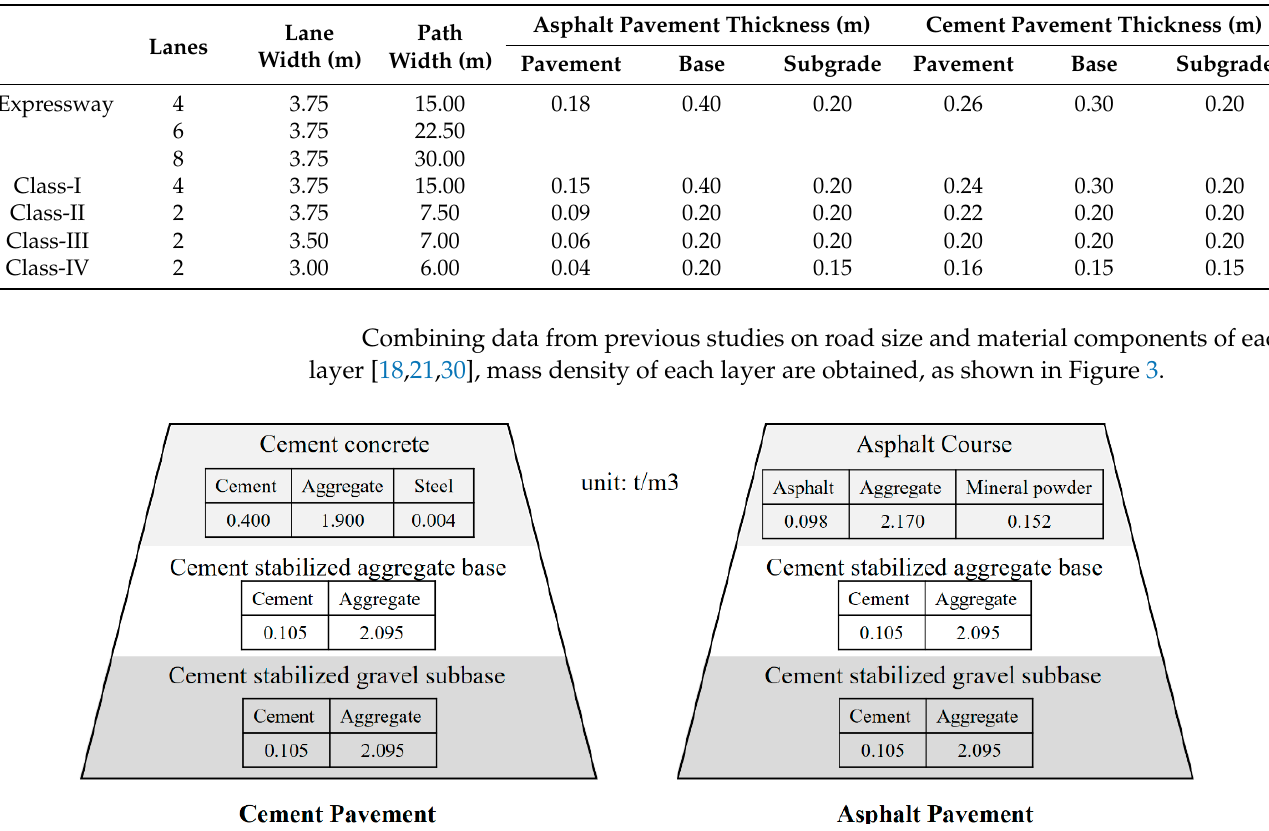
Figure 3. Mass density of raw materials of cement and asphalt pavement.